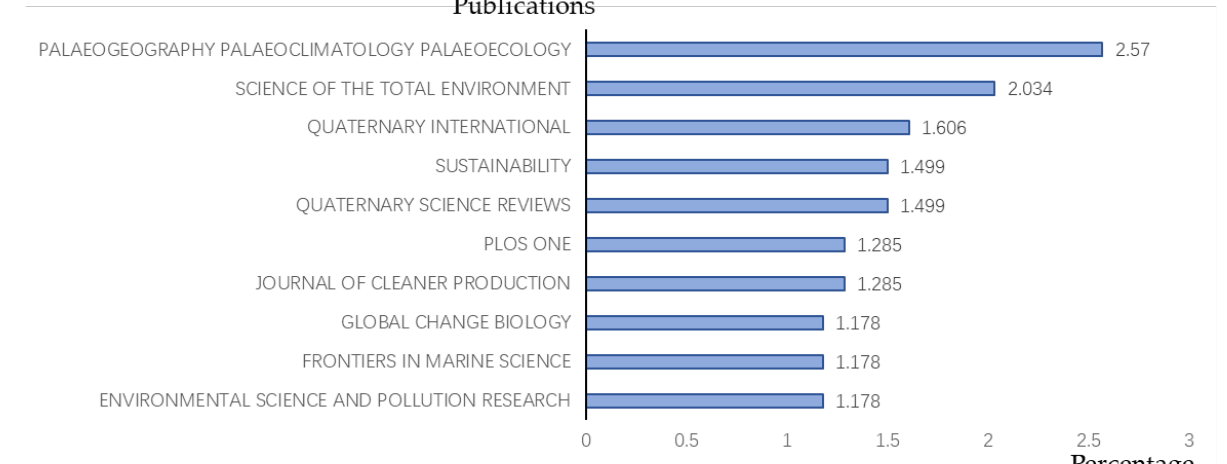
Figure 3. Distribution of RCHSCC disciplines (top 20).